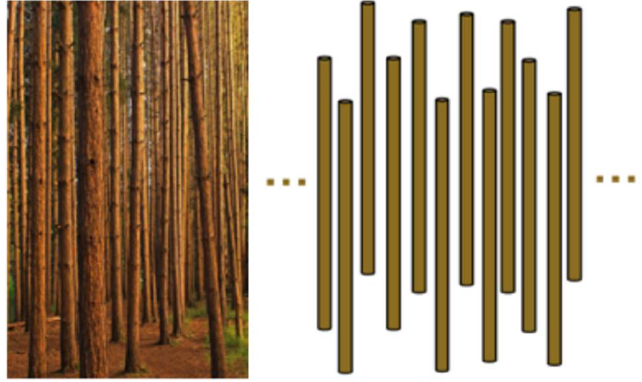
Figure 6. Tree trunks ( left ) are modelled as dielectric cylinders ( right ). The Figure is adapted with